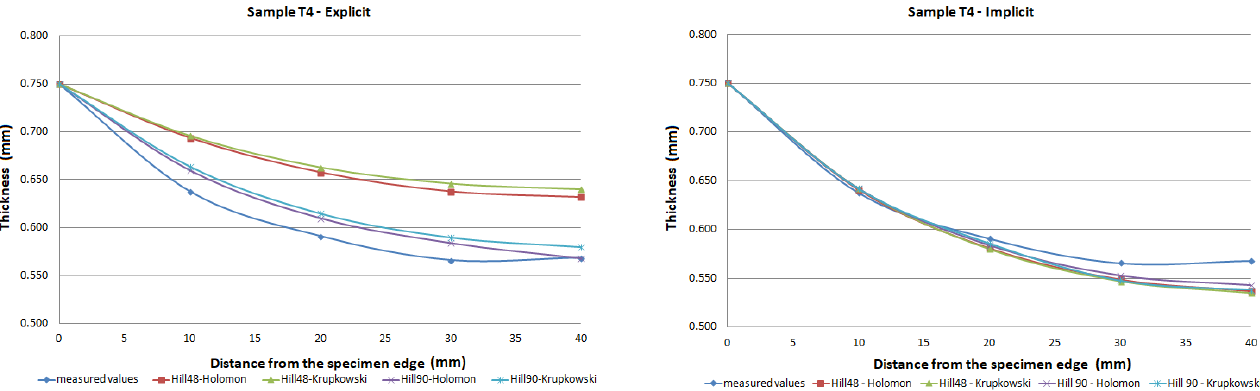
Figure 15. Comparison of predicted and measured thickness values of sample T4 using different types of yield criteria, hardening laws and integration scheme.